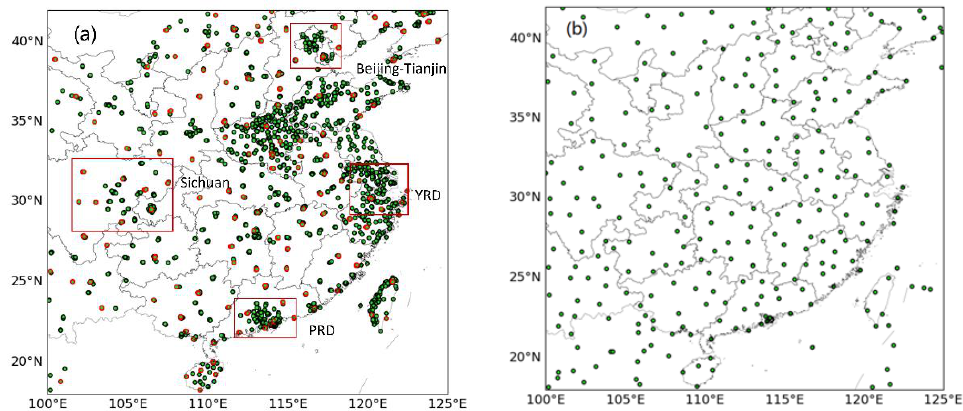
Figure 1. ( a ) Spatial distribution of PM 2.5 monitoring sites (AQMS) included in this research (the red dots indicate the sites for calibration, and the green dots indicate the sites for validation). ( b ) Spatial distribution of meteorological data monitoring sites (GTS) included in this research.